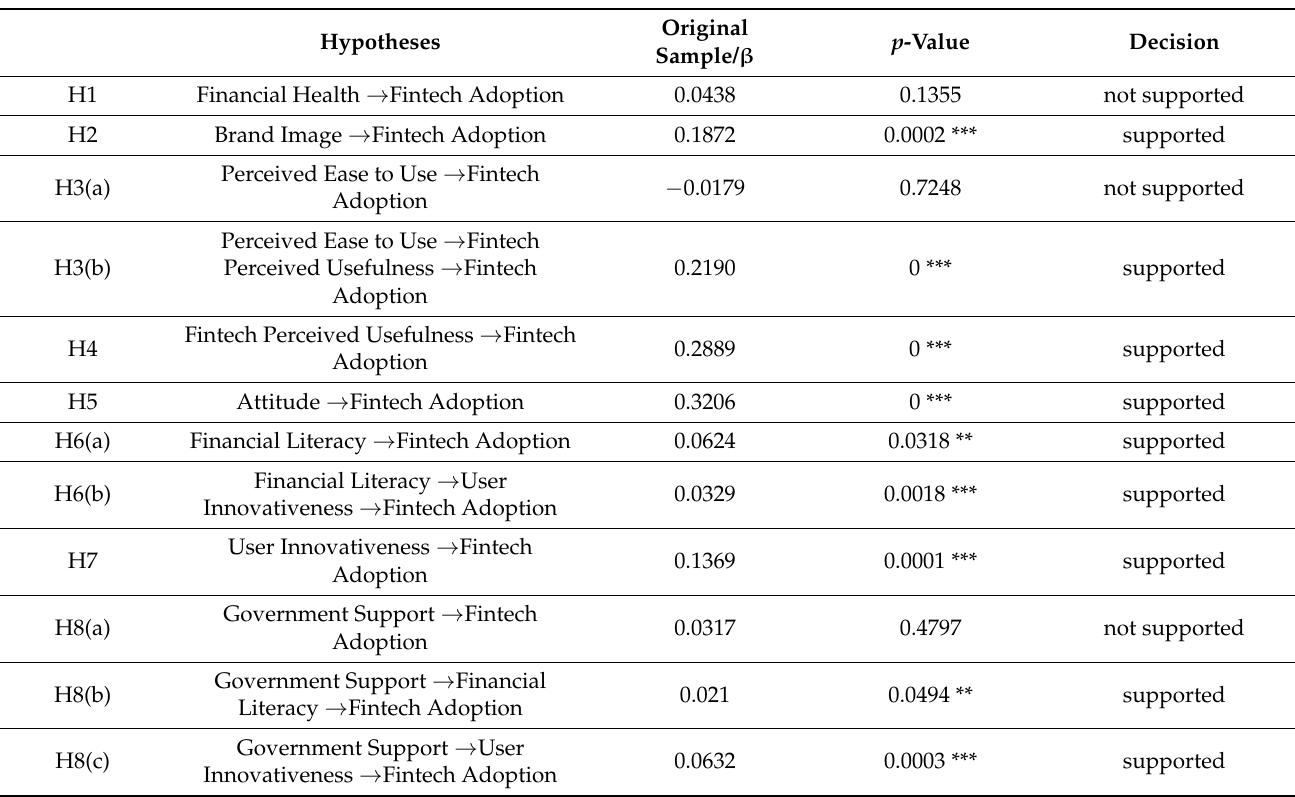
Table 8. Hypothesis